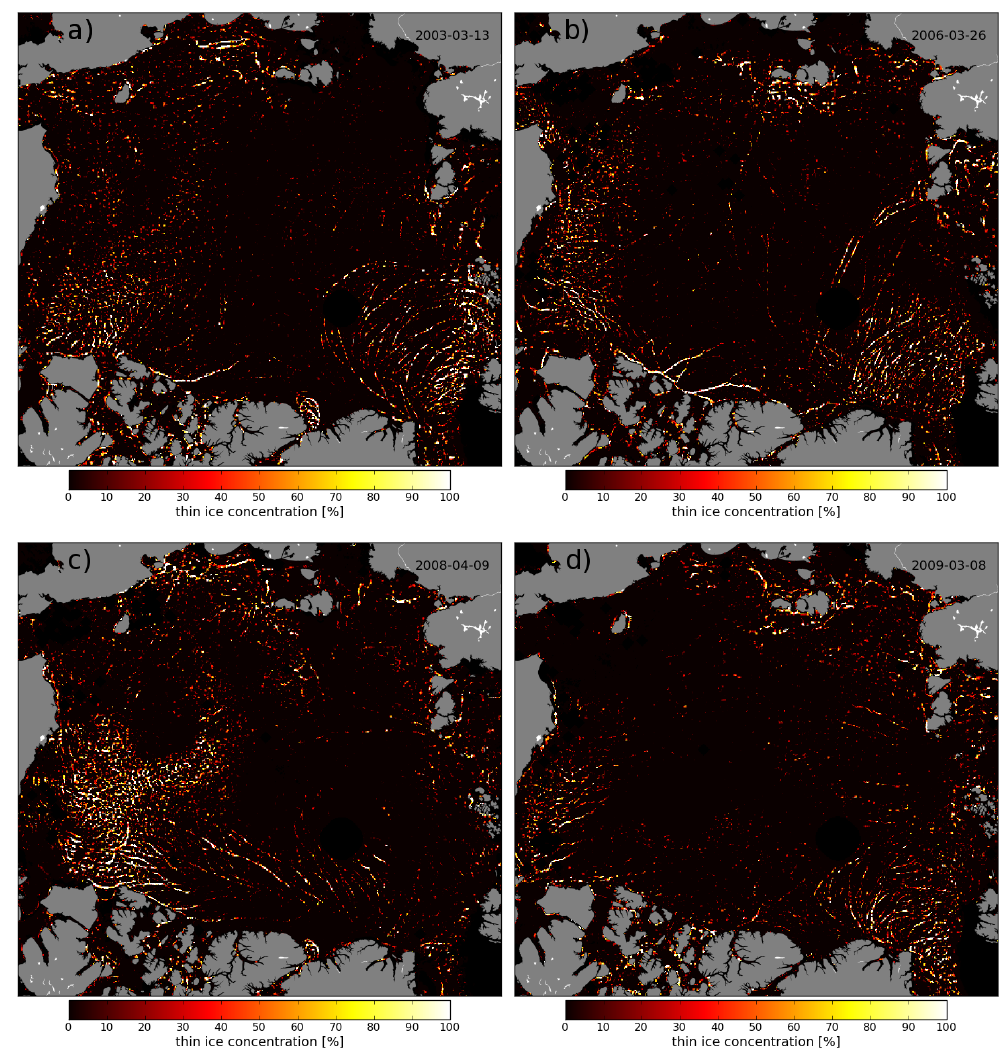
Fig. 4. Thin ice concentrations in the Arctic Ocean as defined in Sect.